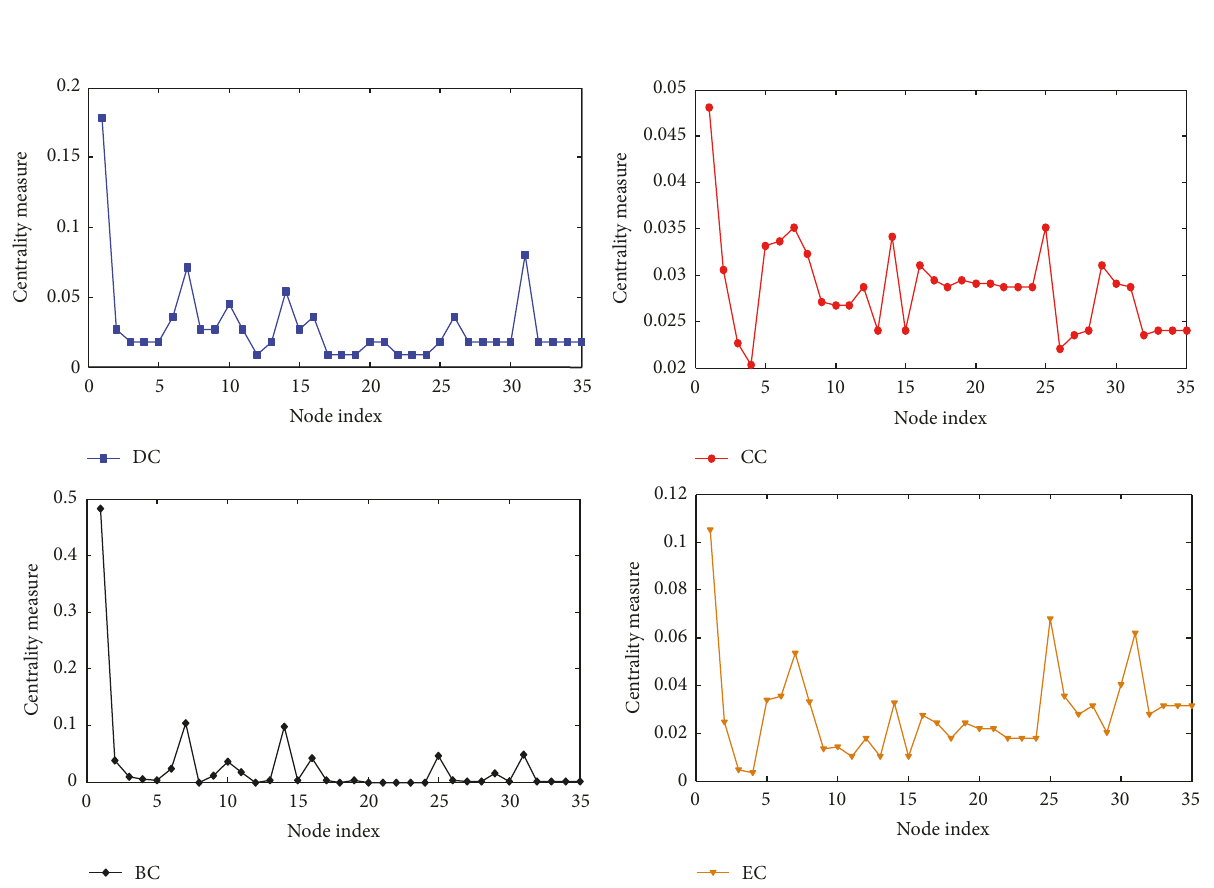
Figure 6: CMs of nodes in the holistic topological